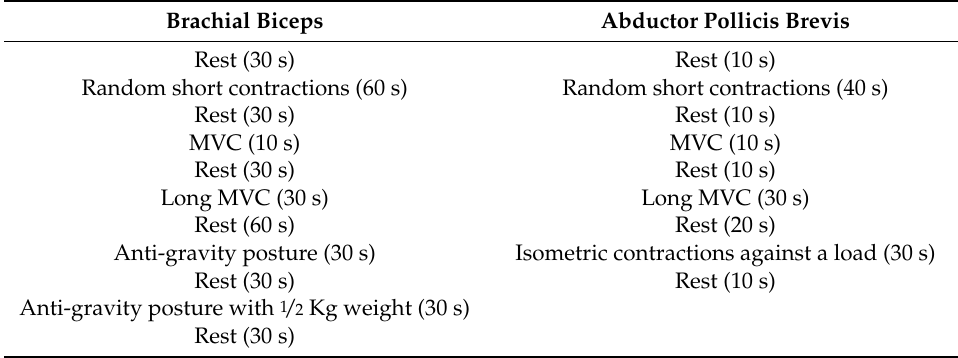
Table 1. Description of the procedures of two typical tests.